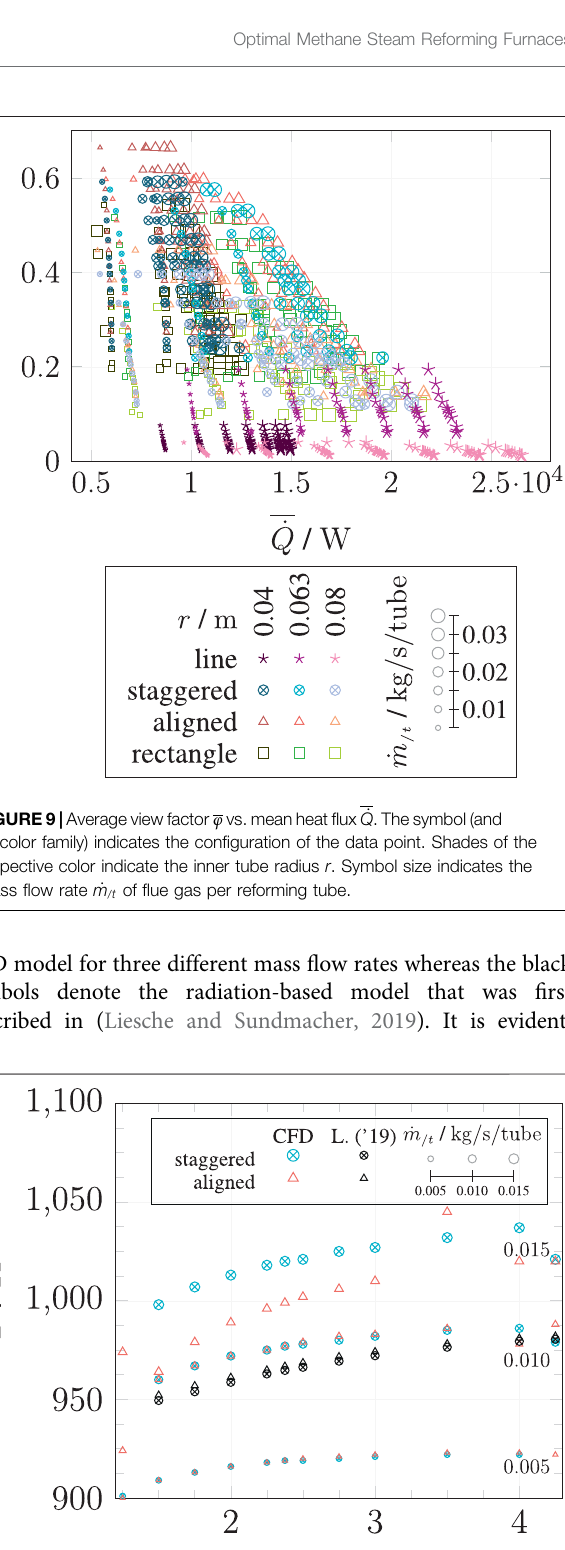
FIGURE10 | Mean tube surface temperature ofall tubes inthe bundle T vs. distance factor h for staggered and aligned arrangements. Results from the radiation-based model (Liesche and Sundmacher, 2019) are marked with black symbols of the respective staggered and aligned